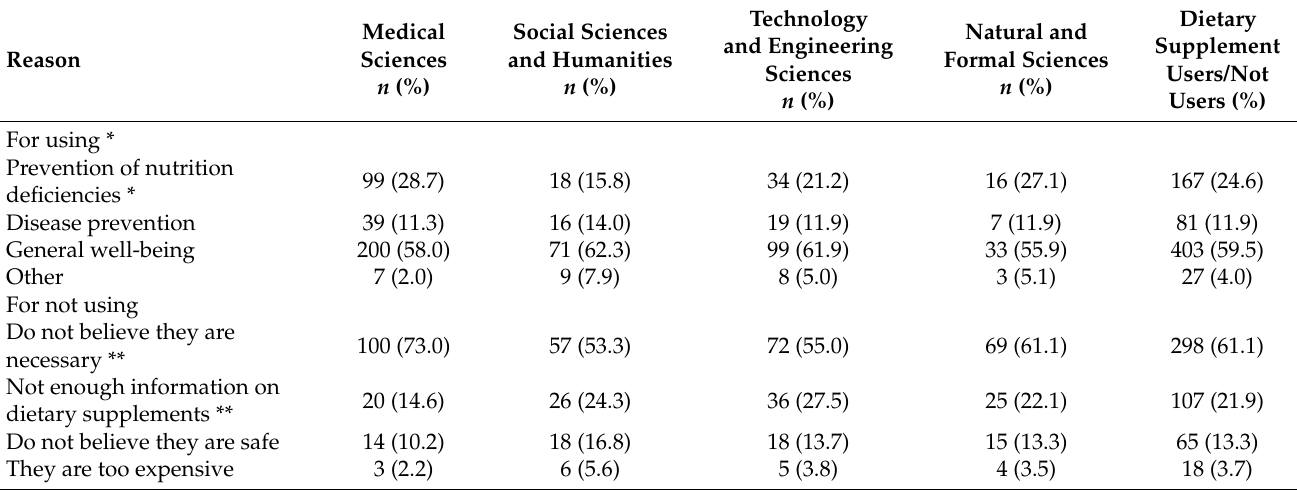
Table 2. Reasons for using/not using dietary supplements among students #